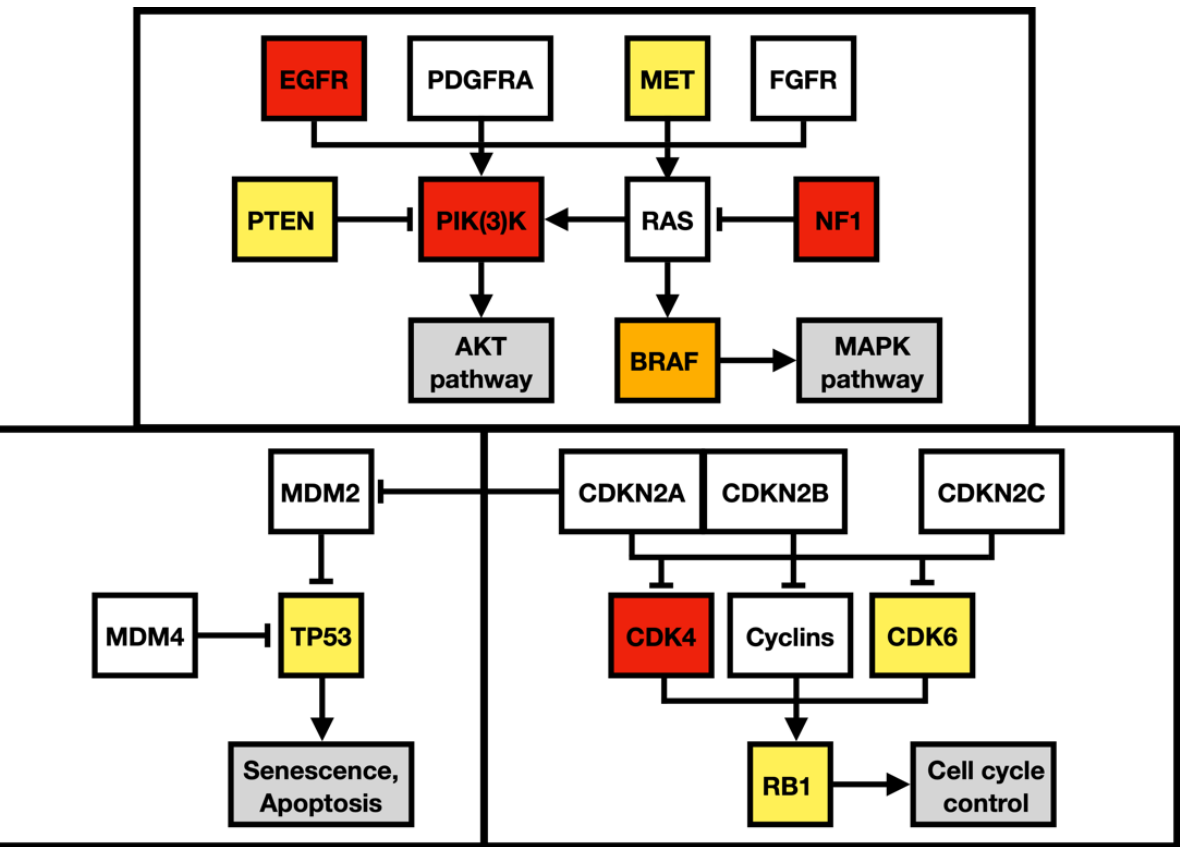
Figure 9. Regulatory pathway alterations in GBM. Altered genes in both primary and metastatic GBM are yellow, altered genes identified only in the primary GBM are orange, and altered genes detected only in the metastatic GBM are red. Adapted from Brennan et al. 2013 and Castellano et al. 2011.